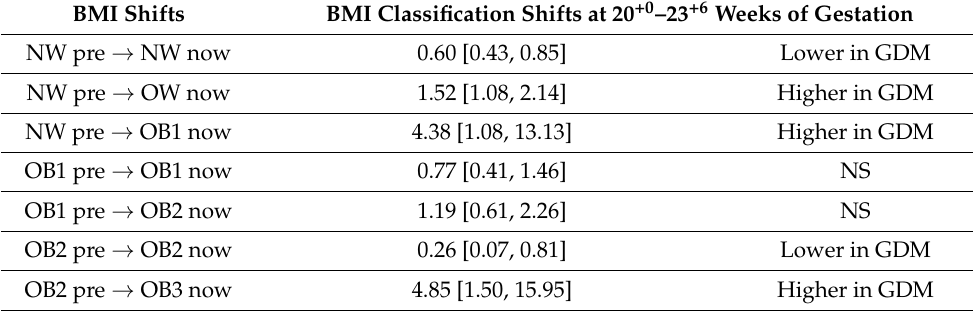
Table 8. Crude analysis of BMI changes at the time of screening for